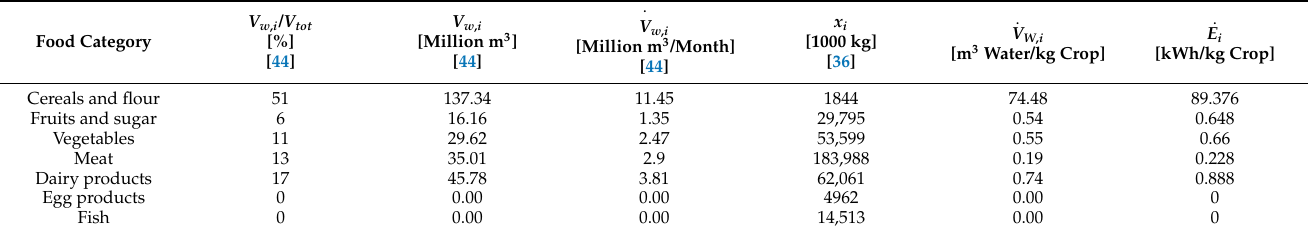
Table 4. The water treatment rates and water consumption shares for each food category in